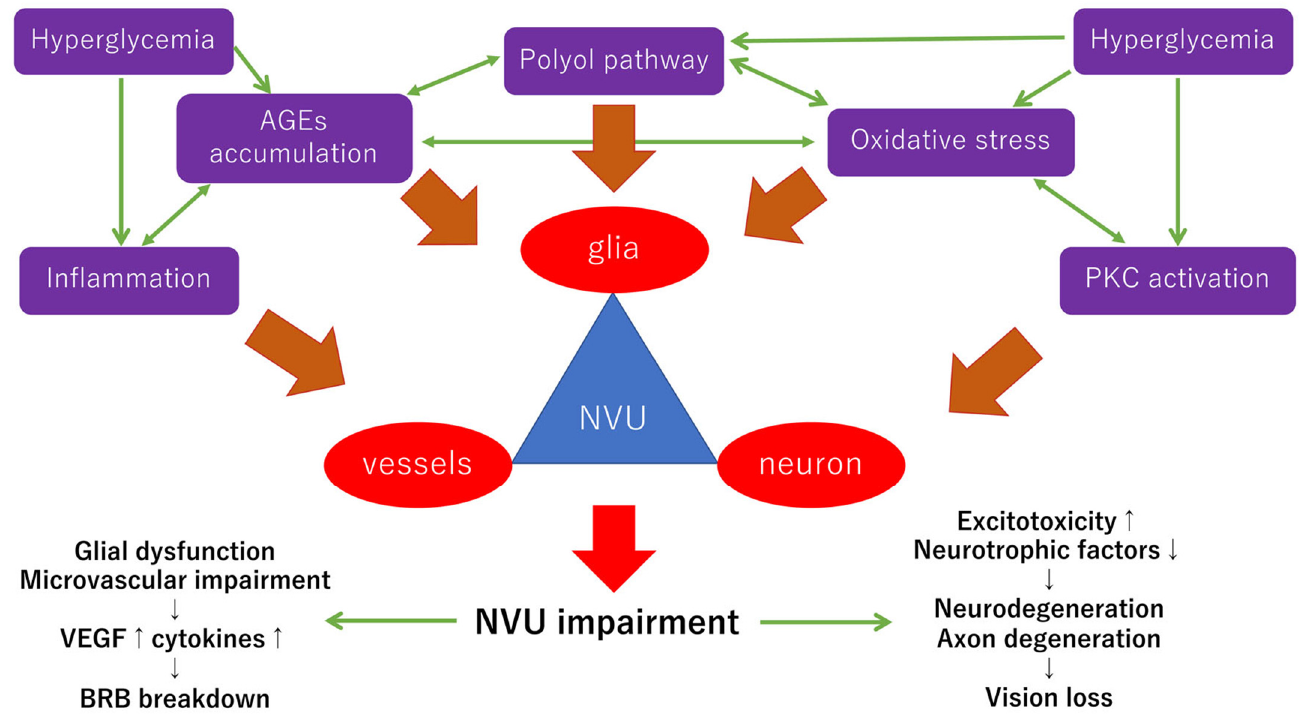
Figure 1. Hypothetical scheme of NVU impairments in early diabetic retinopathy. The NVUs are composed of neurons, glial cells, and vascular cells. Chronic hyperglycemia is a trigger for the impairment of the NVUs. Chronic hyperglycemia causes several stresses, including AGEs accumulation, oxidative stress, inflammation, activation of the polyol pathway, and PKC activation. These stresses lead to glial dysfunction and microvascular impairments, which result in increasing the expression of VEGF and inflammatory cytokines in the eye followed by the BRB breakdown. Neurons and their axons are degenerated by excitotoxicity, neurotrophic factors reduction, which is directly related to vision loss. Most neuronal abnormalities may be independent of the vascular abnormalities in the early stage of diabetes. Not all stresses such as the hexosamine pathways are included in the figure because of the limited space, and the hexosamine pathways may be involved in the late stage of the pathogenesis of diabetic retinopathy [44]. NVU: neurovascular unit; AGEs: advanced glycation end-products; PKC: protein kinase C; VEGF: vascular endothelial growth factor; BRB: blood–retinal barrier.